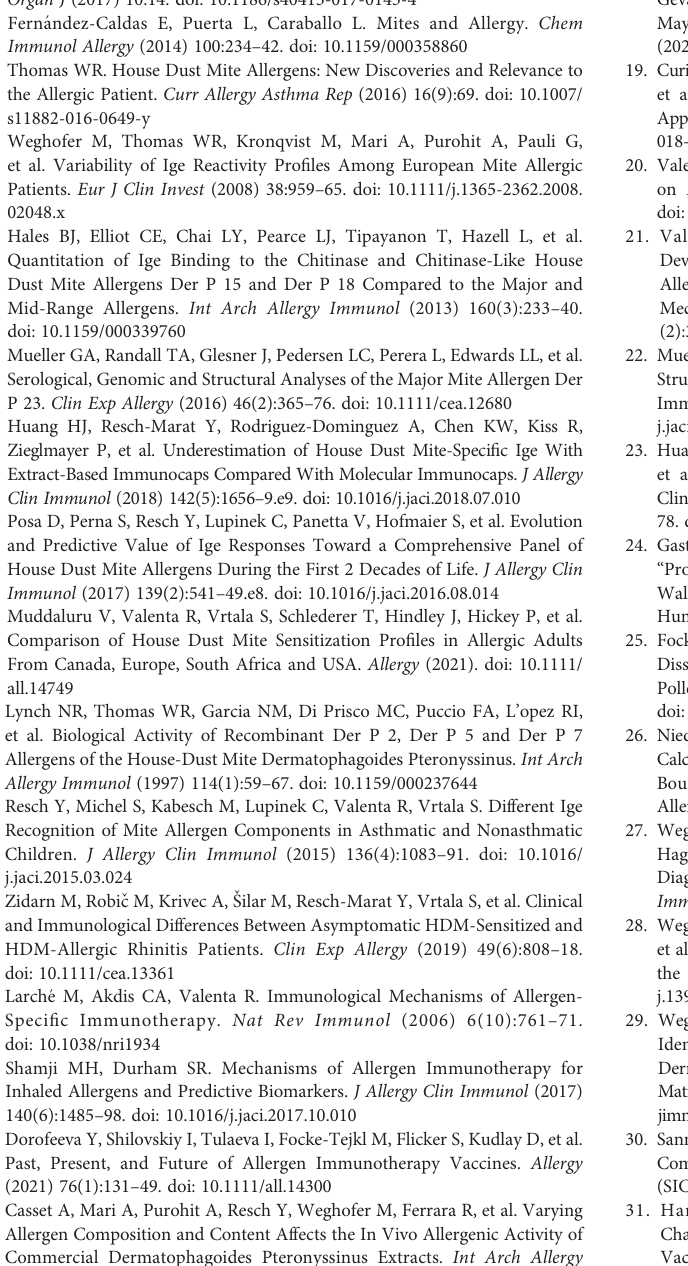
rabbits per peptide). IgG reactivity of sera from immunized rabbits to ELISA plate- bound Der p 7 was determined for different dilutions (x-axes) of the anti-sera